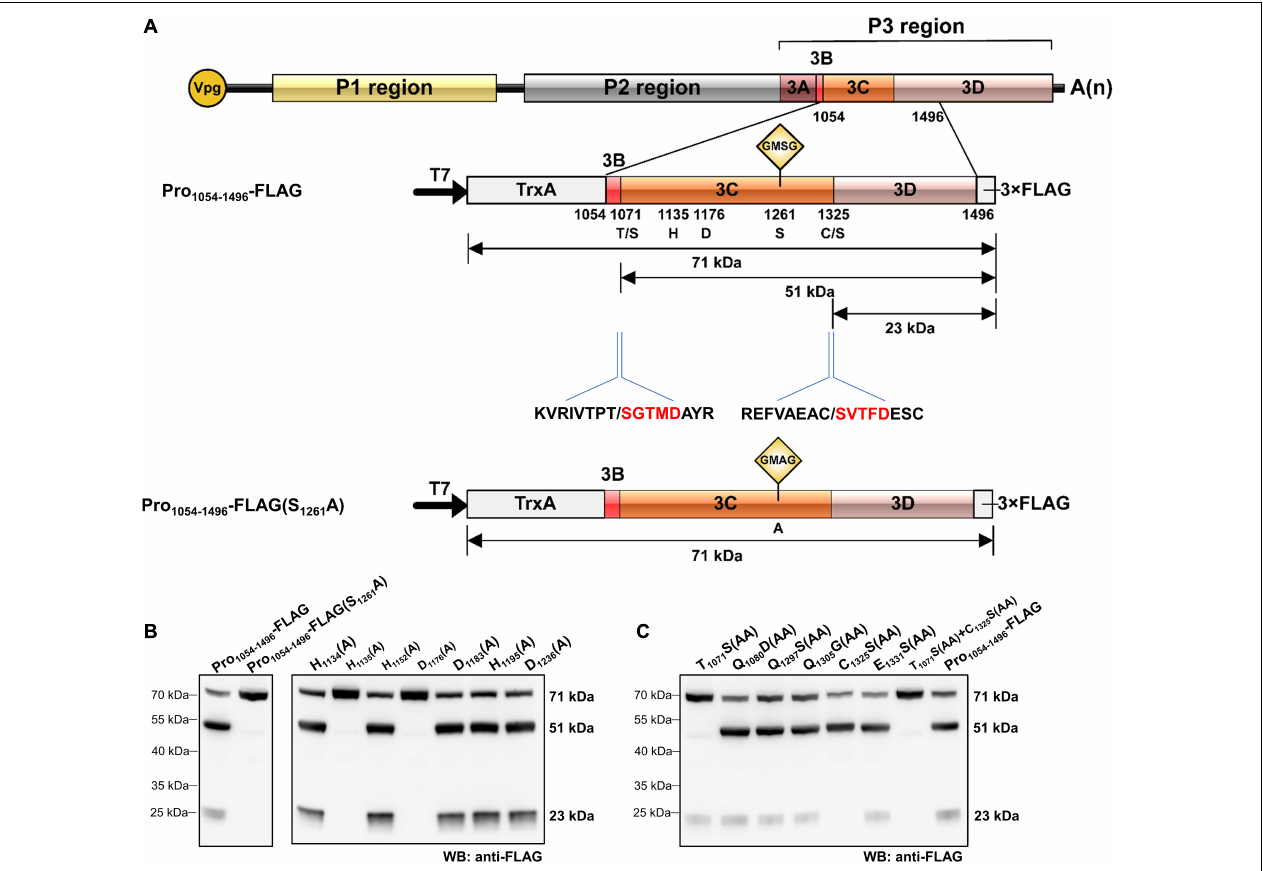
FIGURE 2 | Analysis of rice curl dwarf-associated picornavirus (RCDaV) 3Cpro cis -cleavage activity. (A) Schematic diagrams of RCDaV genome organization, the 3 × FLAG tagged Pro 1054 − 1496 fusion protein (Pro 1054 − 1496 -FLAG) and its mutant. Positions of the site-directed mutations are indicated. A substitution of S to A was introduced at the position 1261 in Pro 1054 − 1496 -FLAG to generate a mutant Pro 1054 − 1496 -FLAG(S 1261 A). The first five aa residues of the cleaved products were determined via the N-terminal Edman degradation sequencing, and are shown in red. Slashes indicate the cleavage sites. The calculated molecular masses of the cleaved products, including the vector-derived non-viral sequences, are indicated. (B) In vitro cis -cleavage activities of Pro 1054 − 1496 -FLAG and its mutants with a single aa residue substitution in the catalytic triad. (C) Identification of cis -cleavage sites of RCDaV 3Cpro by in vitro cis -cleavage assays using seven mutants, the dipeptide of predicted cleavage sites was mutated to